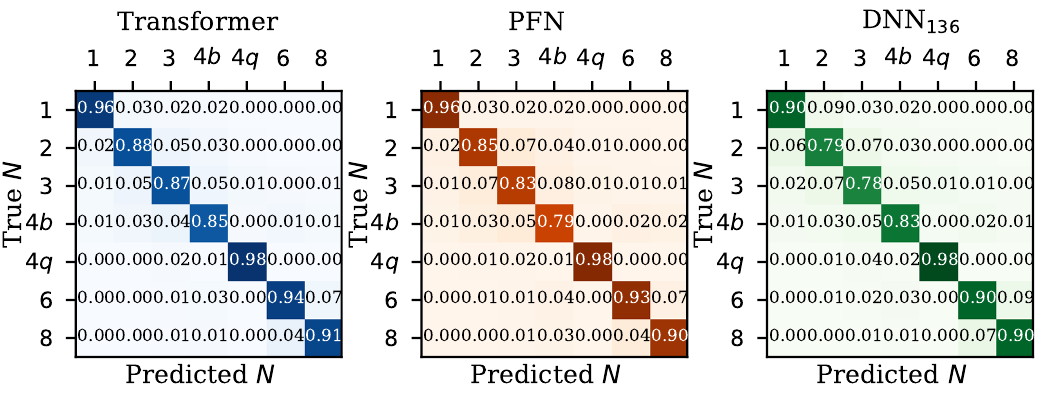
Figure 5 . Confusion matrices of the three network studies. The entries show the frequency at which the networks predict a jet class for a given